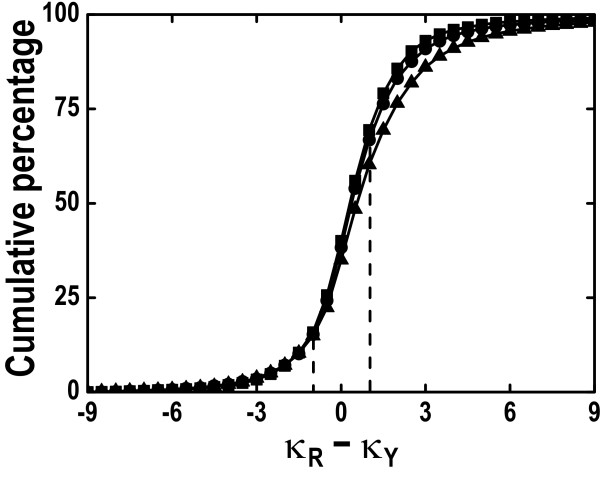
Cumulative percentage of κR – κY for human-mouse (squares), human-dog (circles), and mouse-rat (triangles) orthologs at a bin size of 0.1. Dashed lines were used to show the cases when κR-κY = -1 and κR-κY = 1.